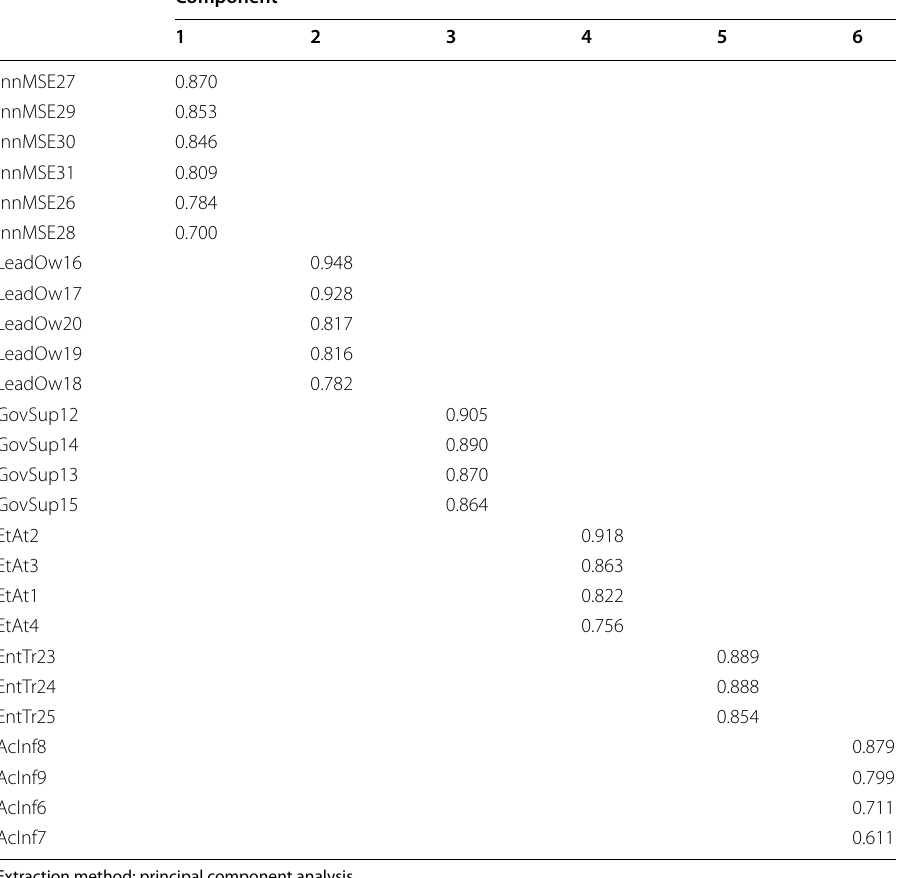
Table 4 Pattern matrix of the study